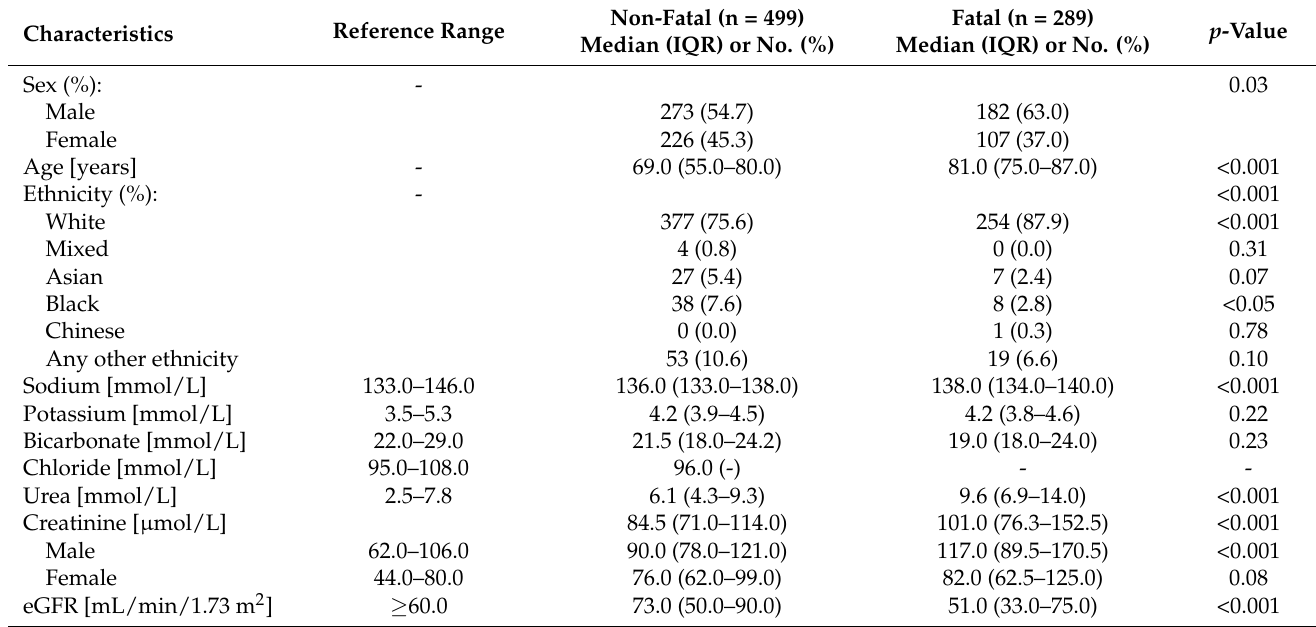
Table 1. Demographics and kidney function